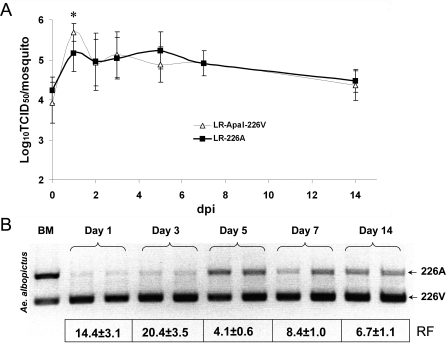
Effect of E1-A226V Mutation on CHIKV Kinetics of Viral Growth in Bodies of Ae. albopictus Mosquitoes(A) Virus production in orally infected Ae. albopictus mosquitoes. Infected mosquitoes were sampled at 0, 1, 2, 3, 5, 7, and 14 dpi and titrated on Vero cells to estimate average titer ± standard deviation of eight whole mosquitoes. Differences in viral titers were analyzed by pairwise t-tests. Asterisk indicates p < 0.05.(B) Kinetics of competition between LR-ApaI-226V and LR-226A in bodies of Ae. albopictus mosquitoes. 107 pfu of LR-ApaI-226V and LR-226A were mixed and orally presented to Ae. albopictus. Infected mosquitoes were sampled at 1, 3, 5, 7, and 14 dpi. For each time point, viral RNA was extracted from two pools of ten mosquitoes.BM - initial ratio of LR-ApaI-226V and LR-226A in blood meal samples.RF - relative fitness of LR-Apa-226V to LR-226A was calculated as a ratio between 226V and 226A bands in the sample, divided to the control ratio between 226V and 226A in the blood meal. Results expressed as average of two replicas ± standard deviation.